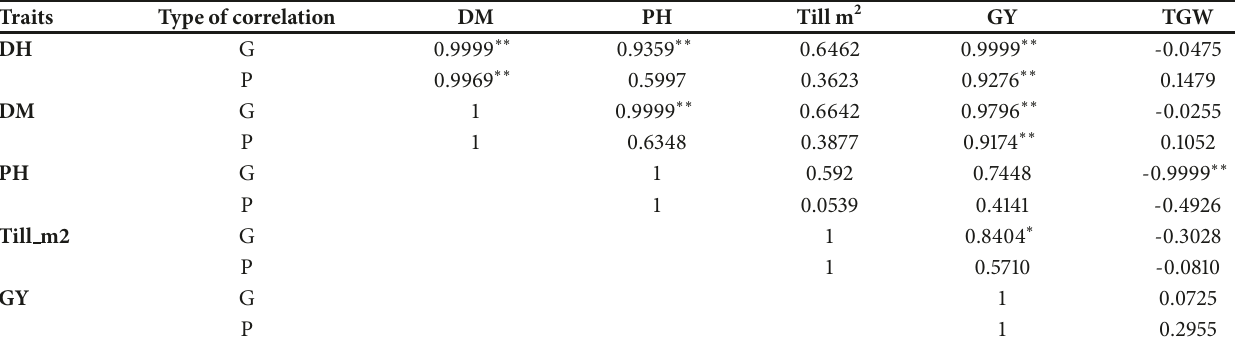
Table 5: Genotypic and phenotypic correlation coefficients of yield and yield attributing traits of rainfed lowland early rice genotypes.